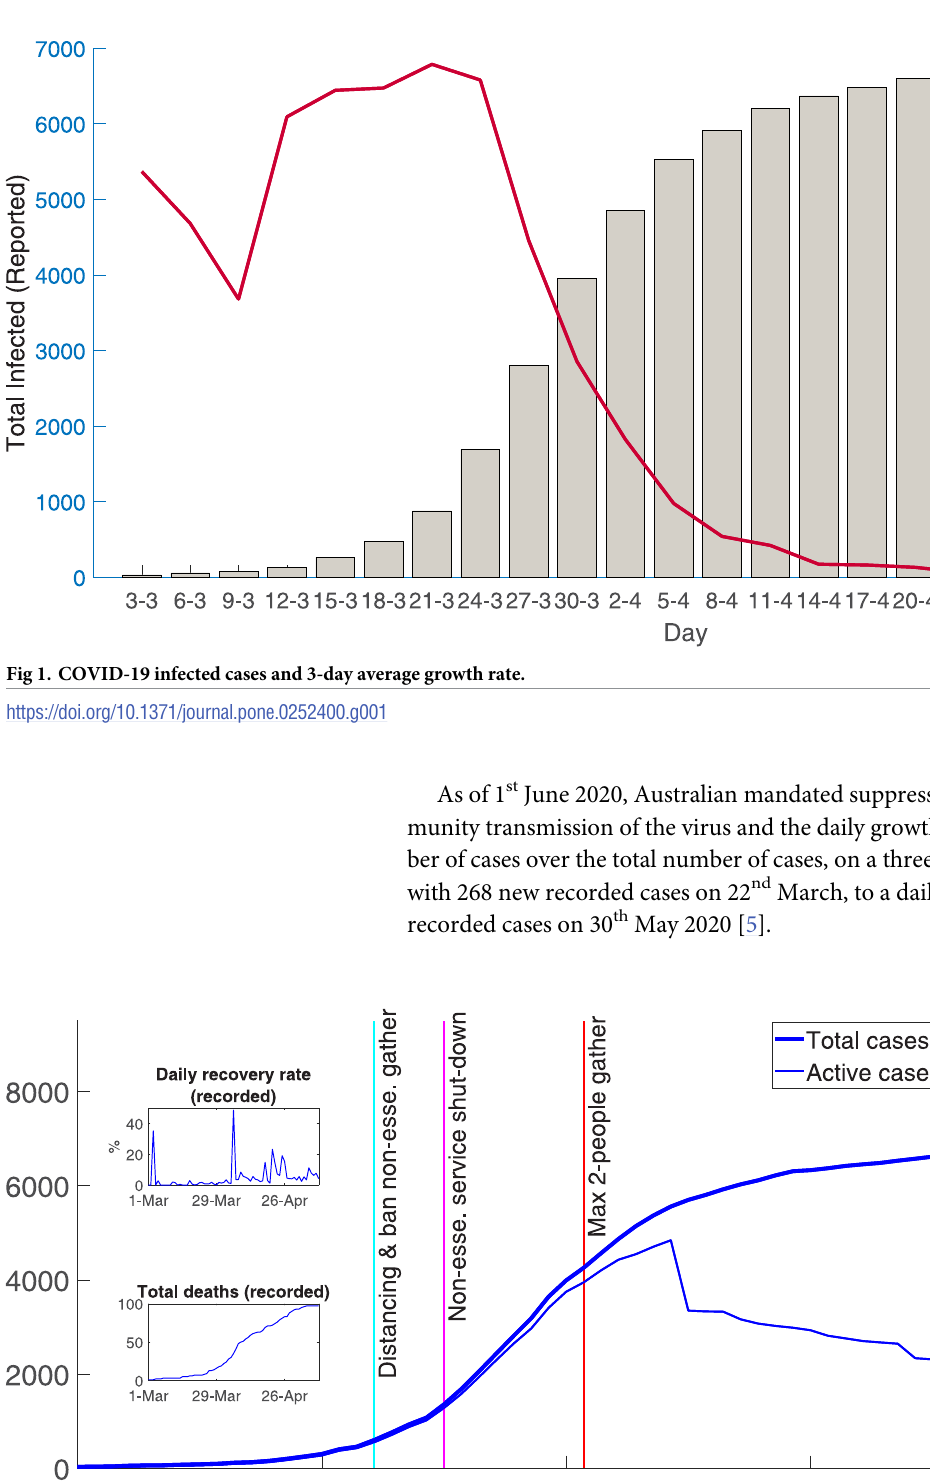
Fig 2. Overview of COVID-19 in